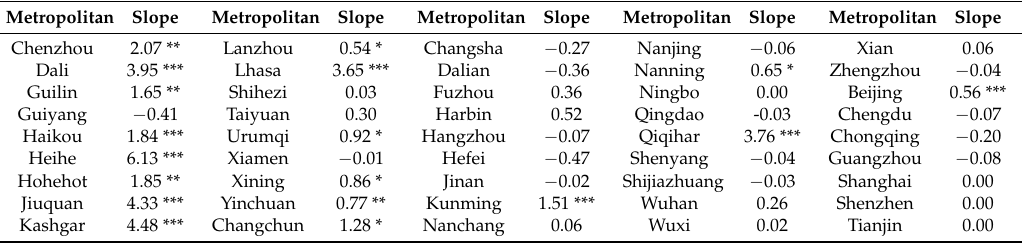
Table 1. Relationships between intensification and expansion over time for individual metropolitans (Note: Slope is the slope value of the linear relationship between IL and EL , * indicates significance at 0.1 level; ** indicates significance at 0.05 level; *** indicates significance at 0.01 level).